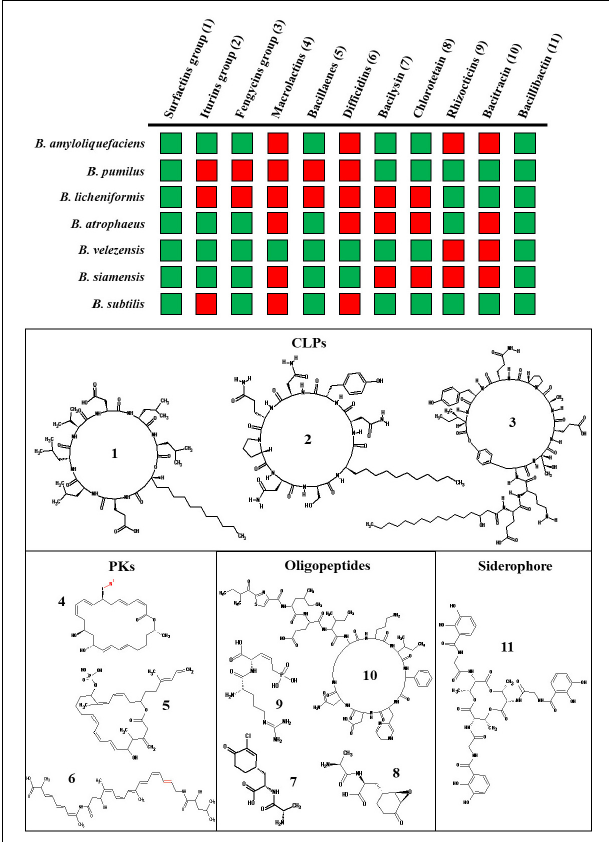
FIGURE 1 | Main non-ribosomal BSMs produced by the various species in the B. subtilis complex. The BSMs production is indicated for the following species B. subtilis, B. siamensis, B. velezensis, B. atrophaeus, B. amyloliquefaciens, B. pumilus , and B. licheniformis by a green square whereas red square indicates an absence of production of the BSMs in this species (Zhao and Kuipers, 2016; Fan et al., 2017; Harwood et al., 2018; Du, 2019; Torres Manno et al., 2019). The surfactins, iturins, and fengycins groups include lichenycin (1;AA1:L-Gln) and pumilacidin (1;AA4: L-Leu, AA7 = I-Ile); mycosubtilin (2;AA6: D-Ser, AA7 = L-Thr) and bacillomycin (2; AA6: D-Ser, AA7 = L-Asn); maltacin (4;AA1: L-Ser), agrastatin (4;AA10: L-Val) and plipastatin (4;AA9: D-Tyr), respectively. The structure of the representative metabolite is indicated by a number and represented below. The possible variations in the PKs structure are highlighted in red. For the macrolactin family, the main variants are R = H; CO-CH 2 -COOH; CO-CH 2 -CH 2 -COOH or 6- O -succinyl- β -glucose (for review see Piel,